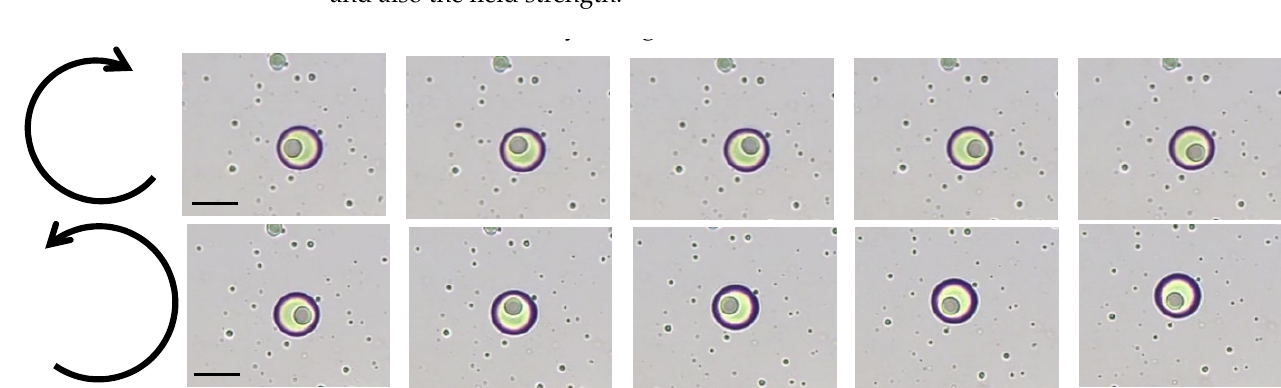
Figure 4. Rotation of the inner silicon droplet clockwise or anti-clockwise by moving an external magnet around the sample (scale bar: 20 µm).